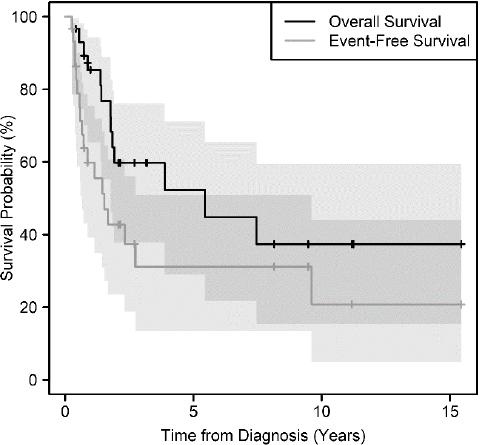
Figure 1. Overall survival and event-free survival distributions for 30 patients with ESFTs of the kidney. Shaded regions are 95% confidence intervals with darker shading where these overlap.